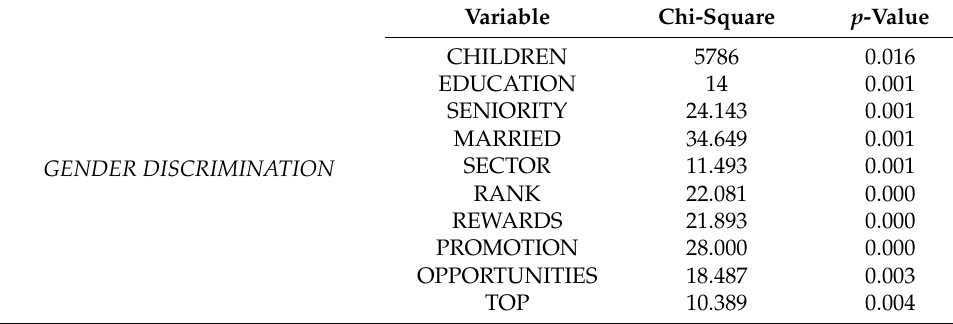
Table 6. Results of the Chi-Square test of the association.